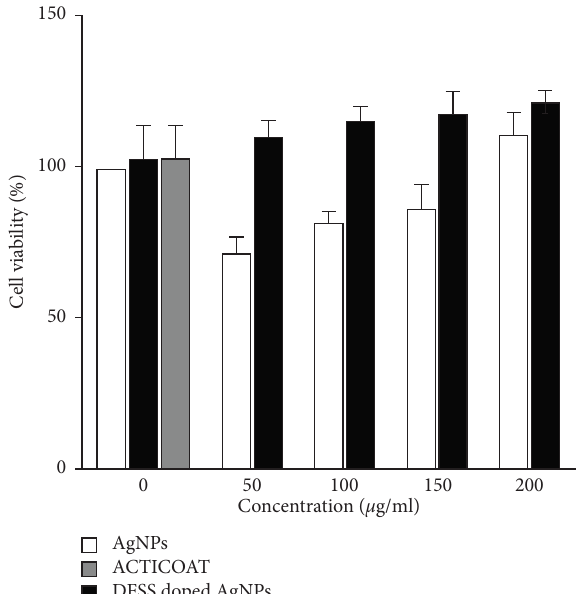
Figure 17: Cell viability at diferent concentrations of mouse fbroblast 3T3 cells obtained using the MTT assay after incubation in DFS scafold, AgNPs, Acticoat, and DFS scafold doped with AgNPs for 48 hours. Each value represents the mean and standard deviation of the triplicate experiment.